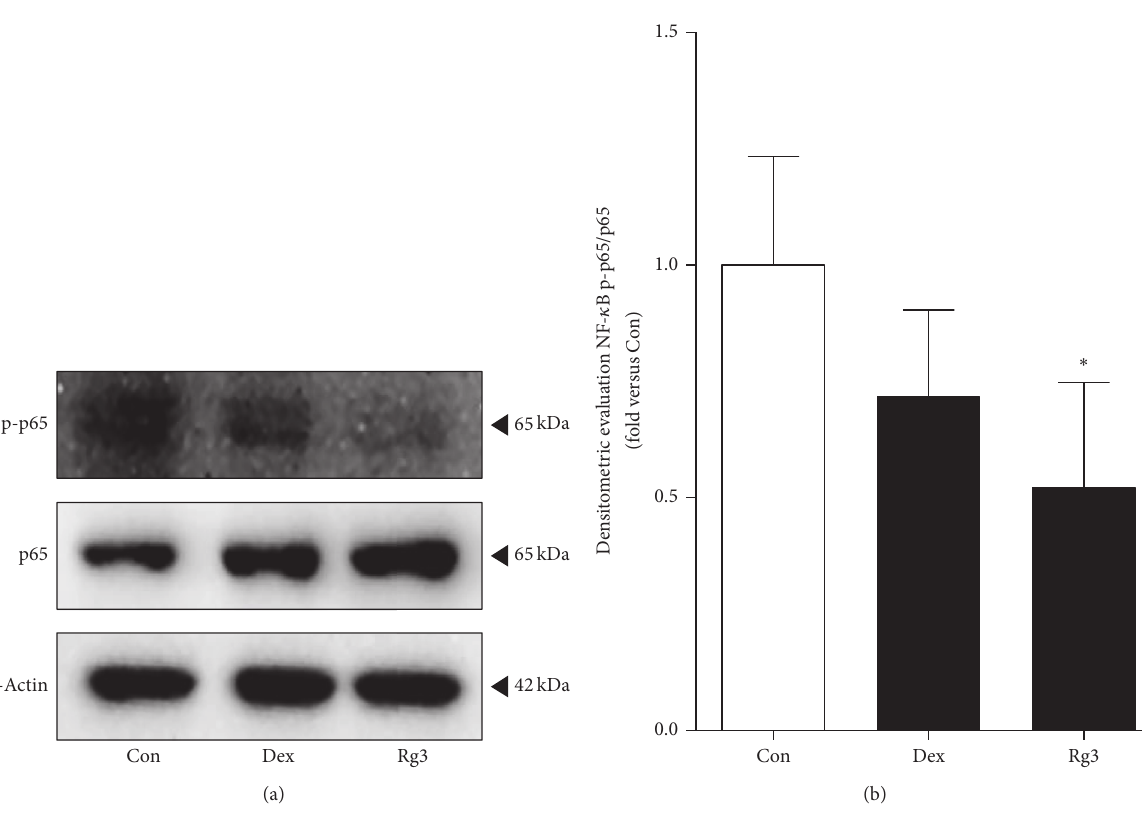
Figure 4: Suppressed NF- 𝜅 B activation by Rg3 in human asthmatic airway epithelial tissues. (a) Human asthmatic lung tissue was treated with Dex for positive control or Rg3, and whole tissue lysates were prepared and then subjected to western blot analysis with anti-NF- 𝜅 B phospho-p65 or anti-NF- 𝜅 B p65 antibodies. Anti- 𝛽 -actin antibody was used as an internal control. (b) Ratio of phospho-p65/p65 expression wasmeasuredbyImageJprogramandrepresentedasbarcharts.Statisticalsignificancewasdeterminedbyunpaired 𝑡 test(one-tail)compared to Con (only PBS-treated asthmatic lung tissue). Values are means ± SEM; ∗ 𝑃 <